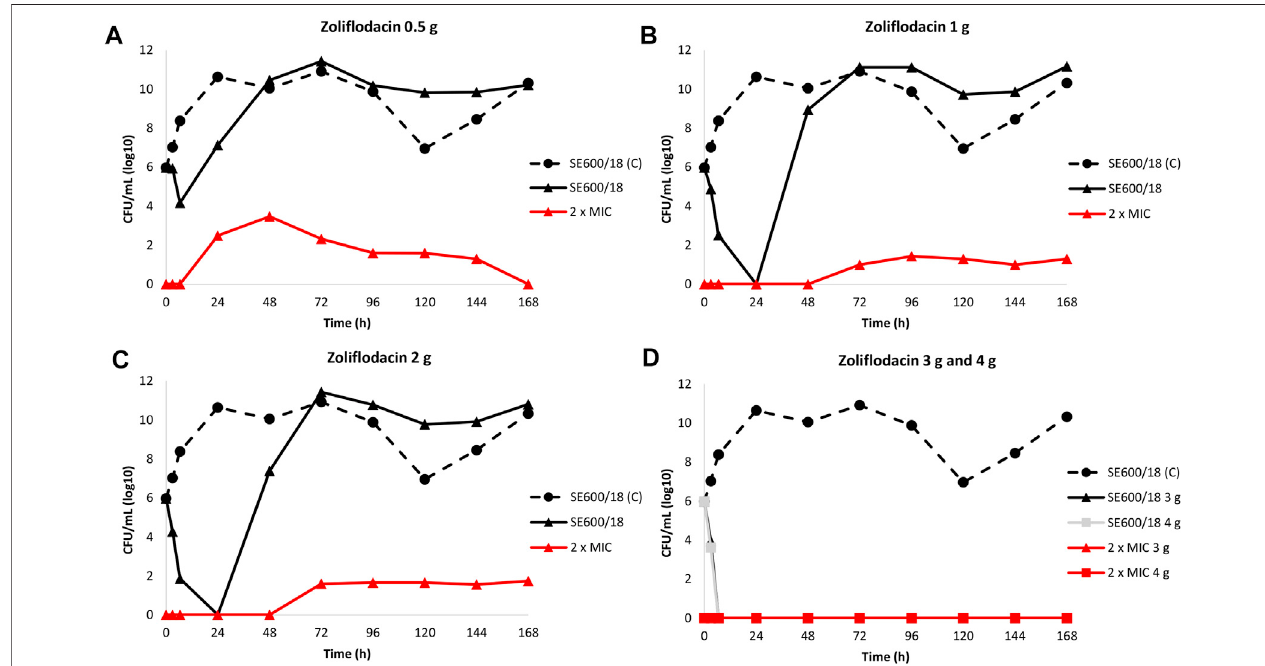
FIGURE 1 | Growth curves of the total population of the clinical zoli fl odacin-susceptible N. gonorrhoeae strain SE600/18, containing a GyrB S467N amino acid substitution, in the dose-range Hollow Fiber Infection Model experiment simulating zoli fl odacin single oral dose of 0.5 (A) , 1 (B) , 2 (C) , 3, and 4 g (D) and followed for 7 daysareshown(blacksolidlines).Thetotalgrowthofzoli fl odacin-resistantpopulations(redlines)onthezoli fl odacin-containingplates(2×MIC)andtotalgrowthofthe untreated control (C; black dashed line) are also shown for each treatment.